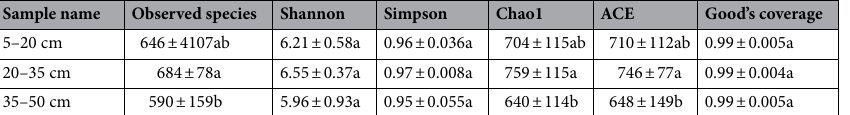
Table 6. Alpha diversity indices of fungal communities in different soil depths. The abbreviations ZN, XZ, HY, WH, GM represent the grape planting years of 5, 8, 10, 12 and 15, respectively. The data in the same column with different lower case letters denote that there is significant difference between the groups ( P < 0.05).